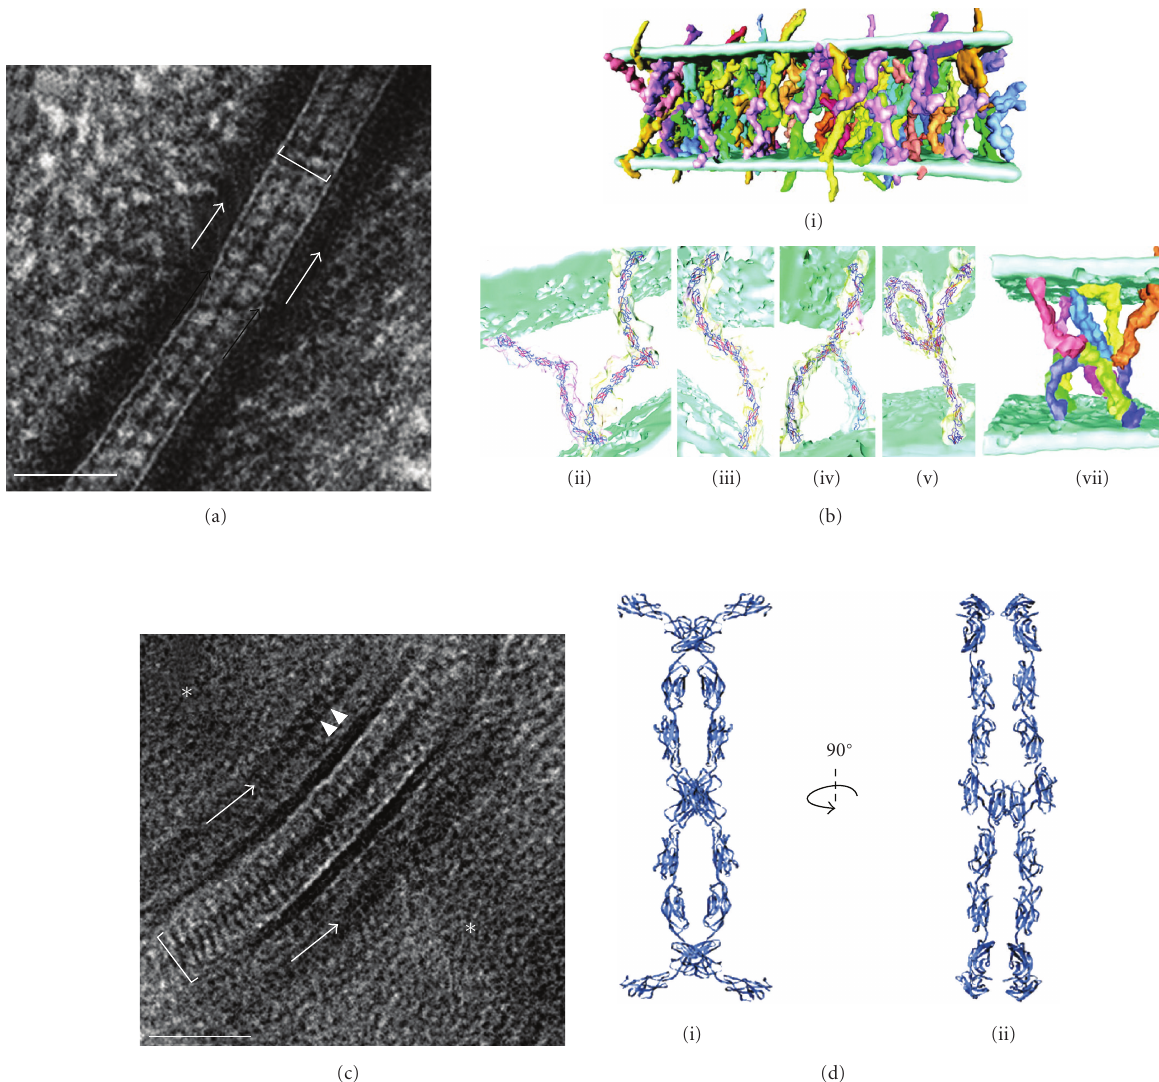
Figure 4: Two models of desmosomal cadherin associations generated from two methods of preparation. A single TEM projection of a newborn mouse epidermis desmosome preserved by high pressure freezing followed by freeze substitution (a). The dense midline is visible bisecting the extracellular core domain (ECD) (white line). Cadherins spanning the extracellular space are separated in an irregular nonsymetrical fashion. A model of cadherin association generated from a dual axis tomogram of newborn mouse epidermis (b i) preserved as in a. C-cadherin crystal structure has been traced onto densities in the ECD believed to be cadherins. The model displays the irregularity of cadherin associations however a dense mid-line is created by tip-to-tip association. The arrangement of cadherins di ff ers to that of the strand dimer model. Three distinct geometries were found resembling the letters W (b ii), S (b iii), and the greek letter λ (b iv). Trans interactions mostly occurred in W and S whereas with λ , cis interactions mostly with S occurred if a third molecule was added (b v). An addition of a third molecule in cis could form a network in associations between up to 6 molecules (b vi). A single TEM projection of a desmosome from vitrified human epidermis processed by cryoelectron microscopy of vitreous sections (c). Densely packed and periodically arranged cadherins can be seen spanning the extracellular space in a straight manner (white line) and associating to form a dense mid-line. A model of cadherin association generated from a single axis tomogram of vitrified human epidermis processed as in c (d). The ribbon representation of the cadherin association model shows a periodic arrangement of curved cadherin densities that are organized with alternating trans and cis associations tip-to-tip. Two distinct geometries were visible in the model. The W shape formed the trans interactions (see d i) whereas the V-shape formed cis interactions resulting in a highly packed regular zipper-like organization. The organization is better visualized when then model is rotated at 90 ◦ from d i, revealing two trans interactions and one cis interaction (d ii). Images 4 B modified from [21] reprinted with permission from AAAS. Images 4 a & c modified from, [65] reprinted with permission from Elsevier, and Images 4D from [22] by permission from Macmillan Publishers Ltd. Scale bars 50